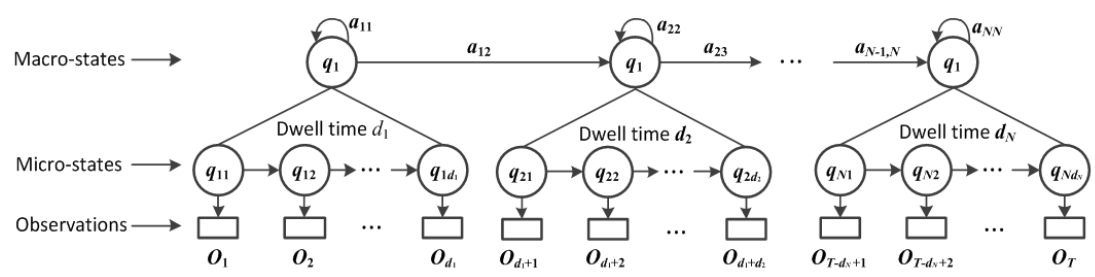
Figure 6. Schematic of HSMM modeling framework.